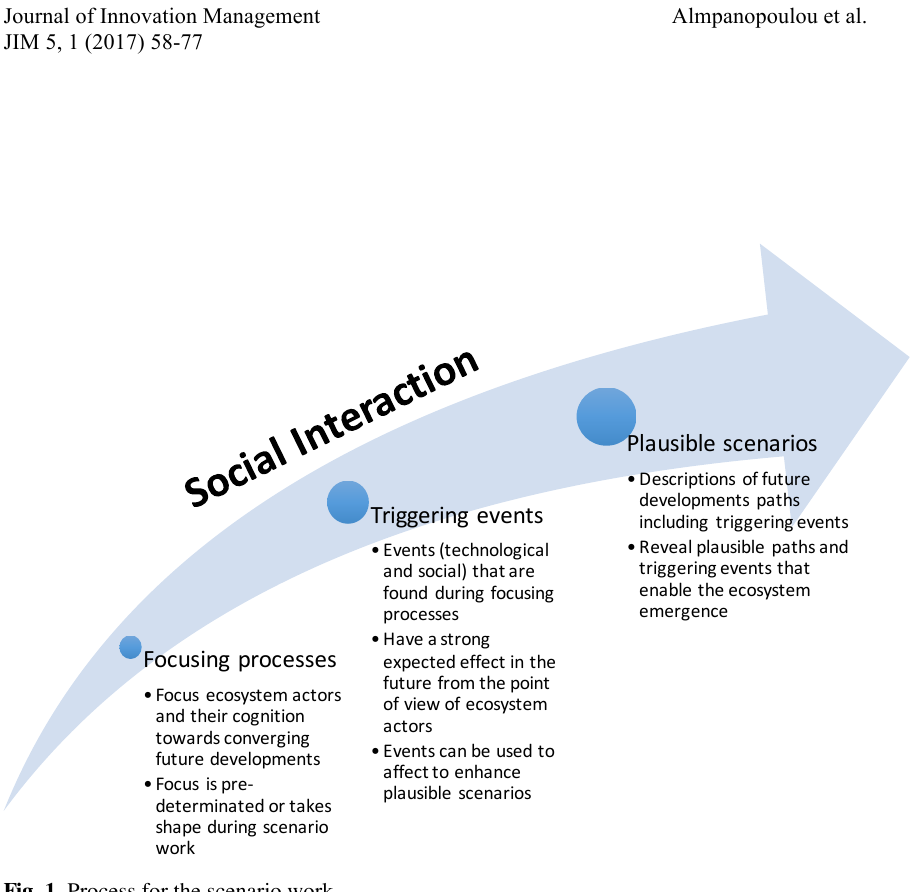
Fig. 1. Process for the scenario